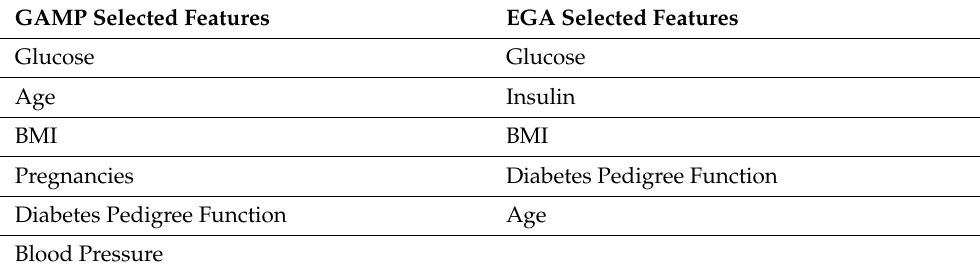
Table 3. Best parameters settings that attained highest Accuracy in